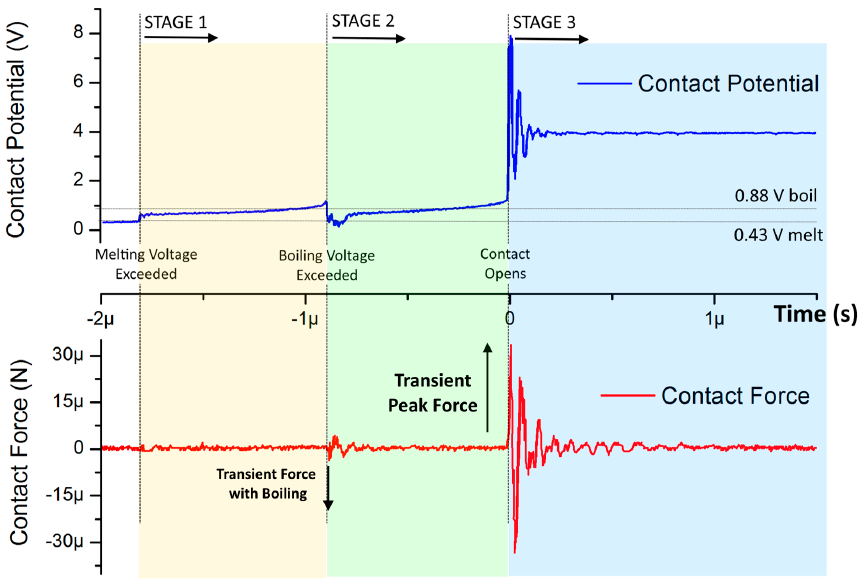
Figure 6. Molten metal bridge contact potential and the corresponding Transient Peak Force.